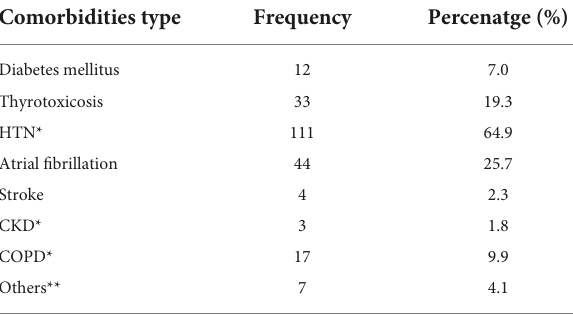
TABLE 3 Co-morbidities of older adult patients with heart failure at Cardiac Clinic, University of Gondar hospital, June 01, 2021 to October 31, 2021 (No. 171).